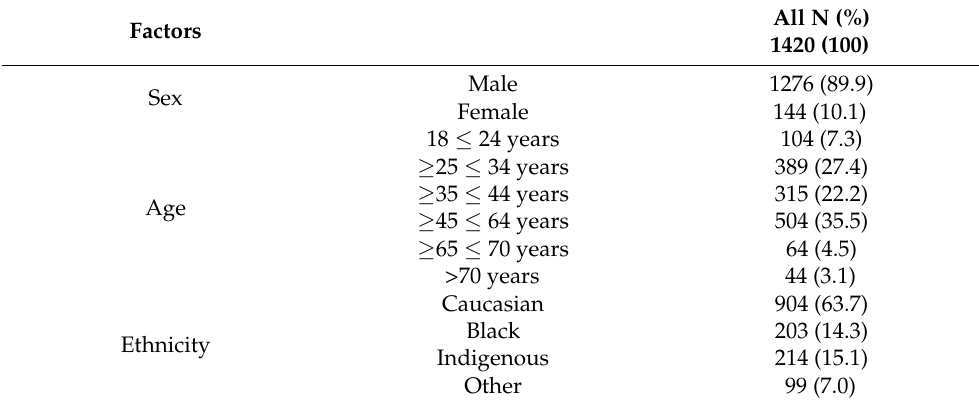
Table 1. Sociodemographic factors from a study sample of incarcerated individuals in Canada (N = 1420).